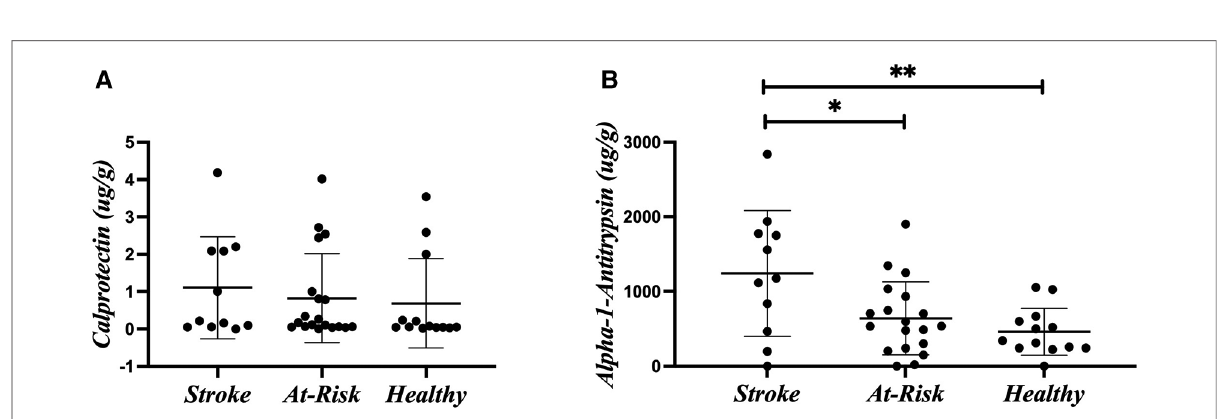
FIGURE 2 Leaky gut markers. ( A ) Calprotectin. ( B ) Alpha-1-antitrypsin. Leaky gut markers were compared amongst the participant groups using Kruskal-Wallis Test. * p -value<0.05; ** p